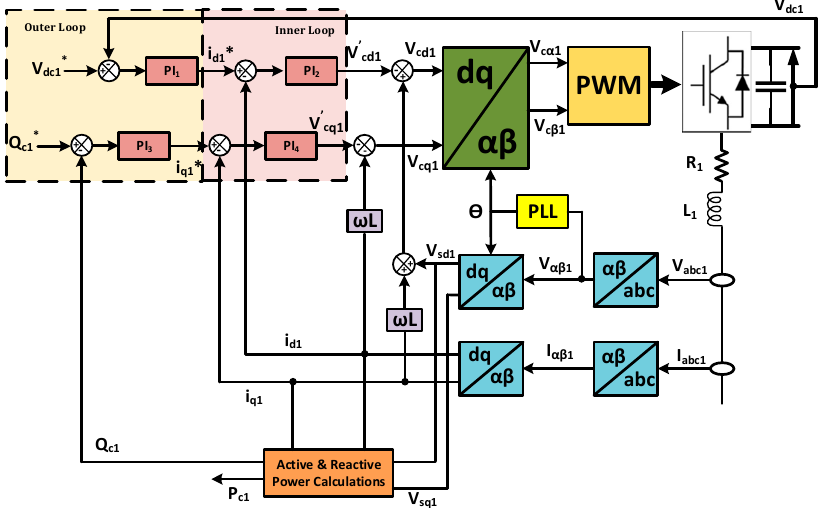
Figure 2. Control scheme at the rectifier station.